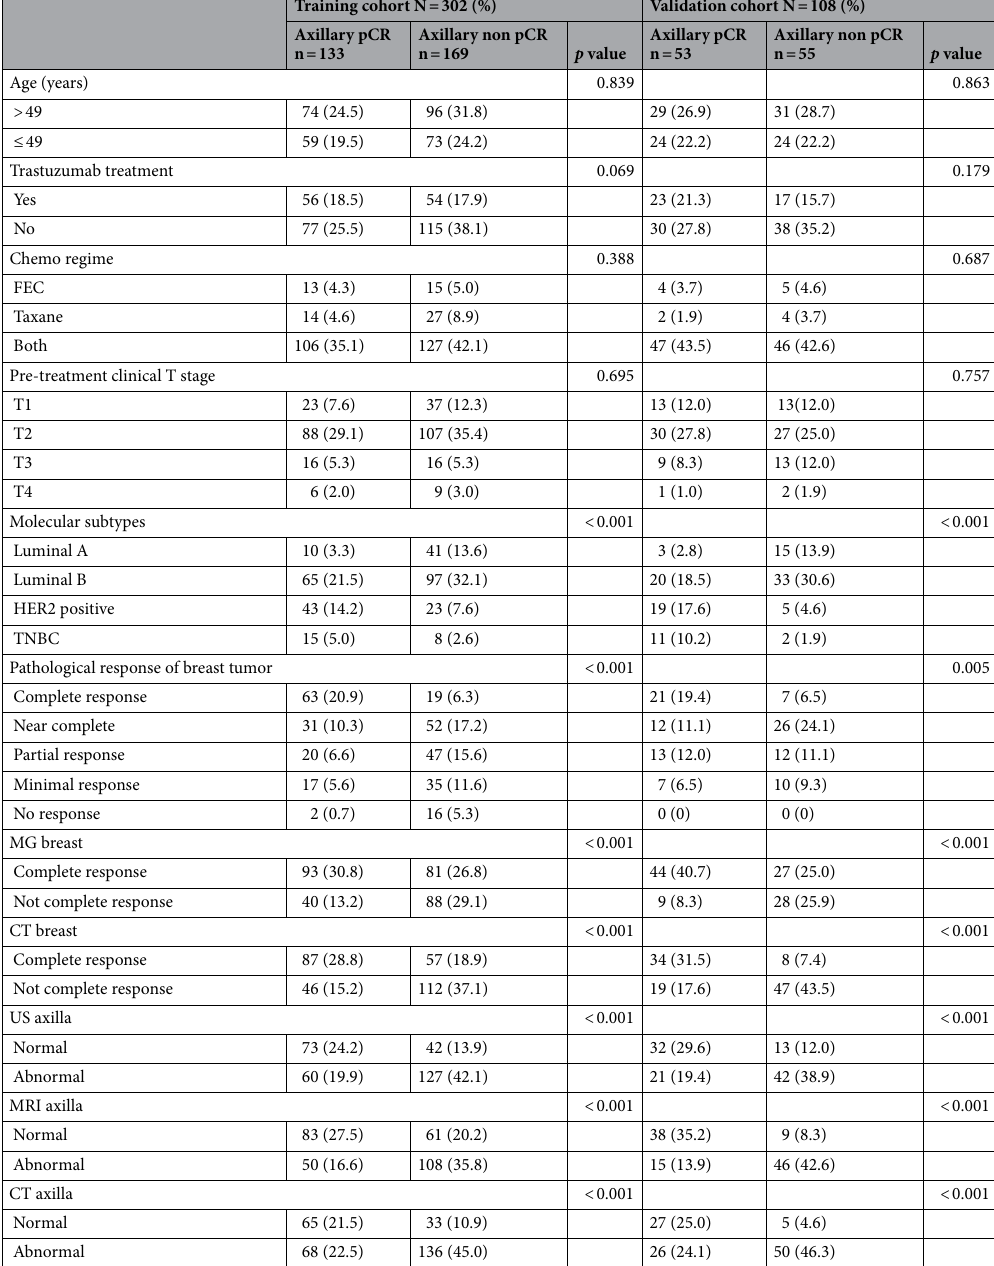
Table 1. Baseline features between patients with or without axillary pCR.(At 3.1). FEC fluorouracil + epirubicin +